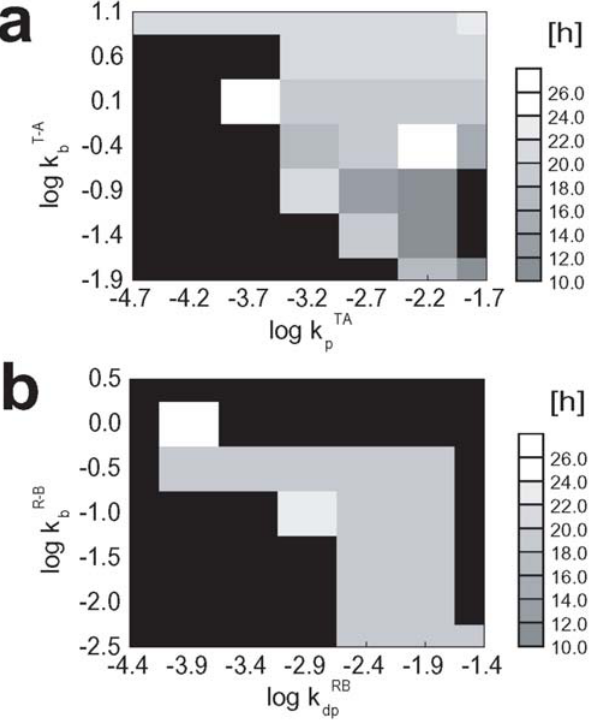
Figure 4. The parameter dependence of the period length of oscillation in the phosphorylation level p(t). The period length is shown in gray scale against (a) log k p TA and log k b T-A or (b) log k dp RB and log k b R-B . The oscillation dies out in the black area.